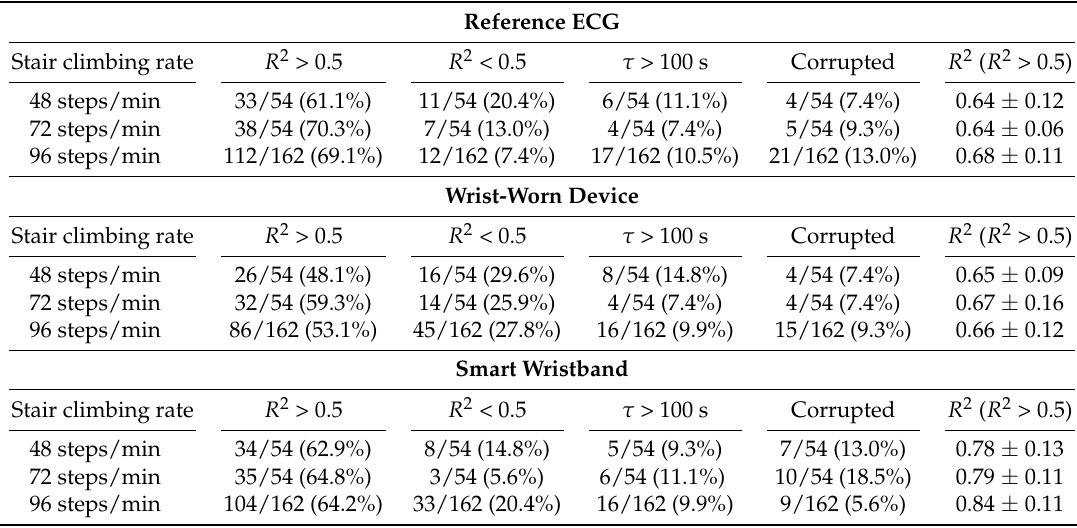
Table 1. Quality analysis of heart rate series acquired for a particular climbing rate. The results are given as the number of heart rate series that satisfy the above stated condition/the total number of heart rate series. R 2 values that met the quality criterion of R 2 > 0.5 are given as mean ± standard deviation. Reference